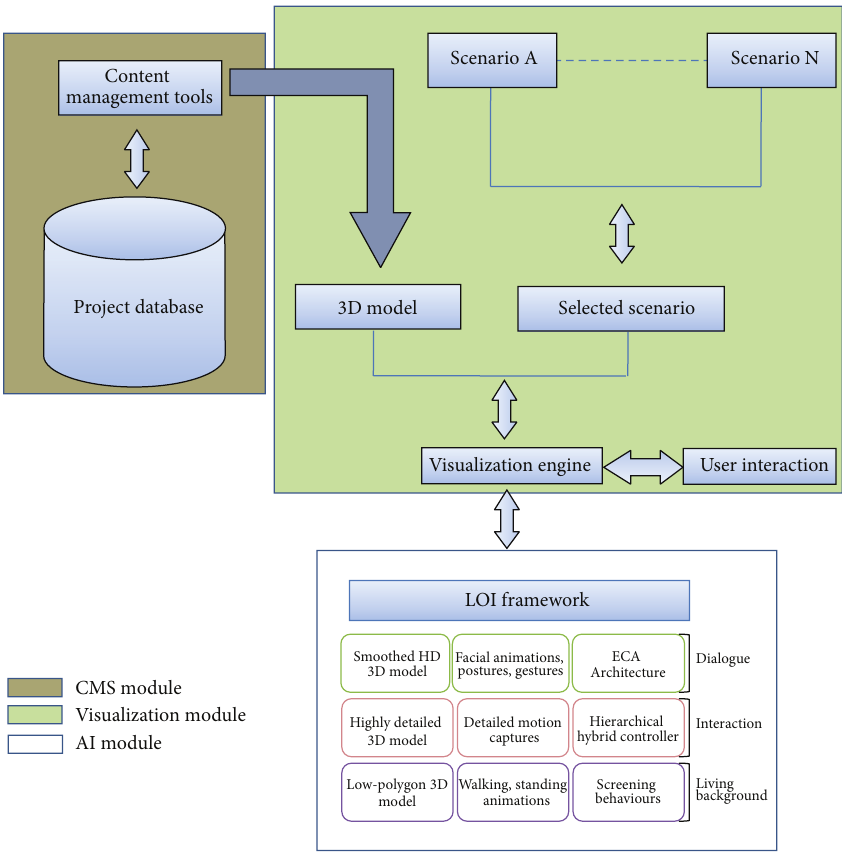
Figure 10: Herbert game system architecture.